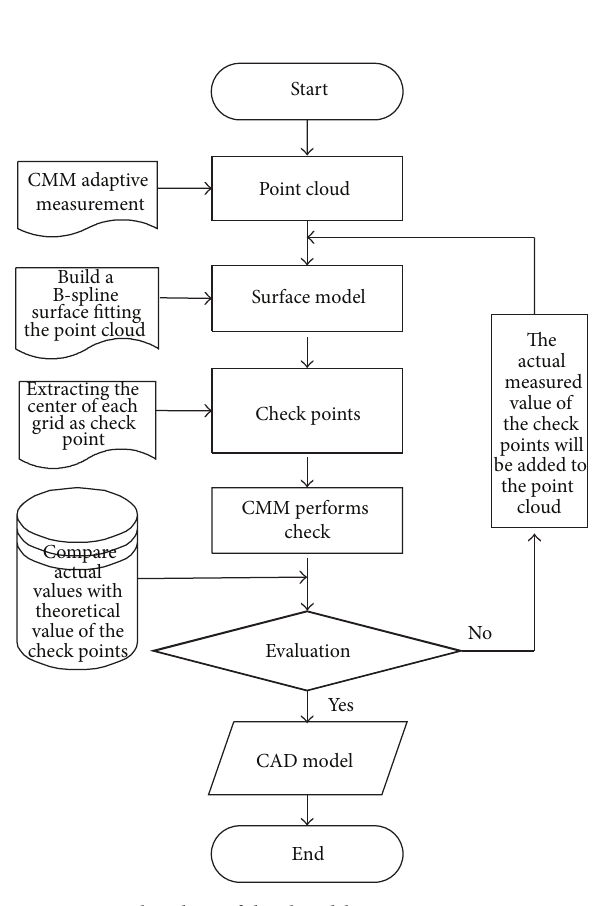
Figure 9: Flowchart of the closed-loop reverse